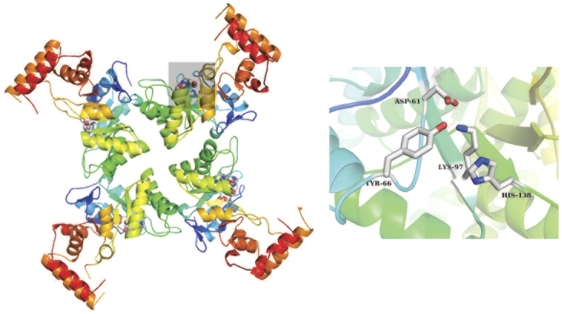
YghZ tetramer and active site.Left, the YghZ tetramer viewed along the four-fold axis. Putative active site residues are depicted as ball-and-stick and colored by atom with the active site of one monomer outlined by a gray box. Right, close -up view of the active site with putative active site residues colored by atom and labeled.